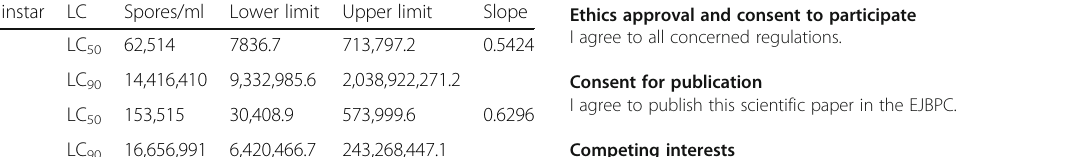
Table 2 Toxicity of the tested Metarhizium anisopliae isolate against L 3 and L 5 larvae of Spodoptera littoralis calculated on seventh day post-treatment Larval instar